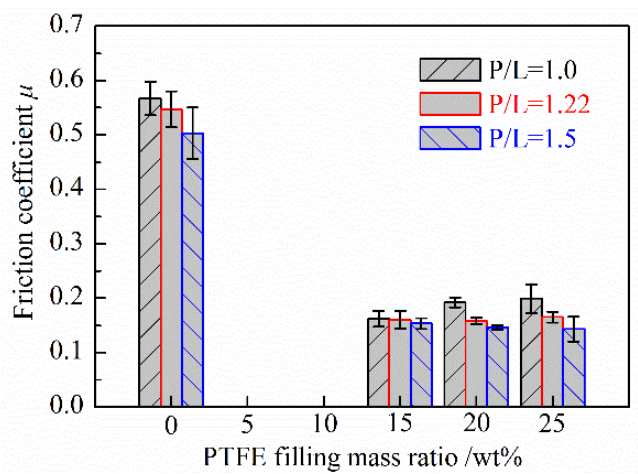
Figure 7. The effect of the filling mass ratio of PTFE and P/L ratio on the friction coefficient of PMMA based composites.